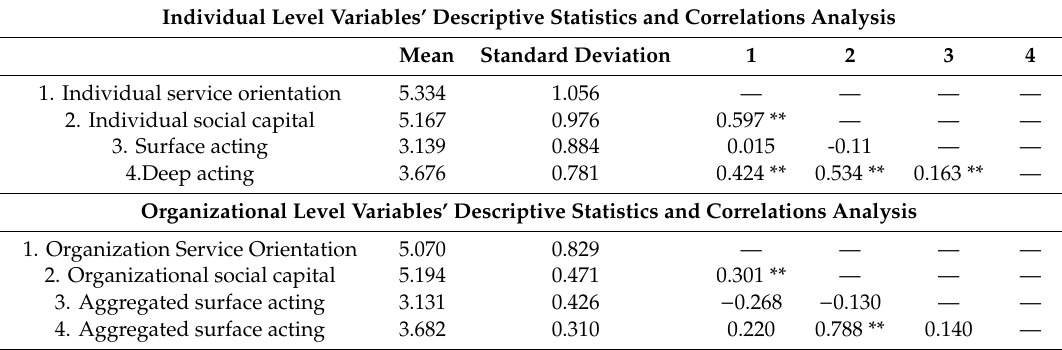
Table 5. Descriptive statistics and correlations for all measures. Individual Level Variables’ Descriptive Statistics and Correlations